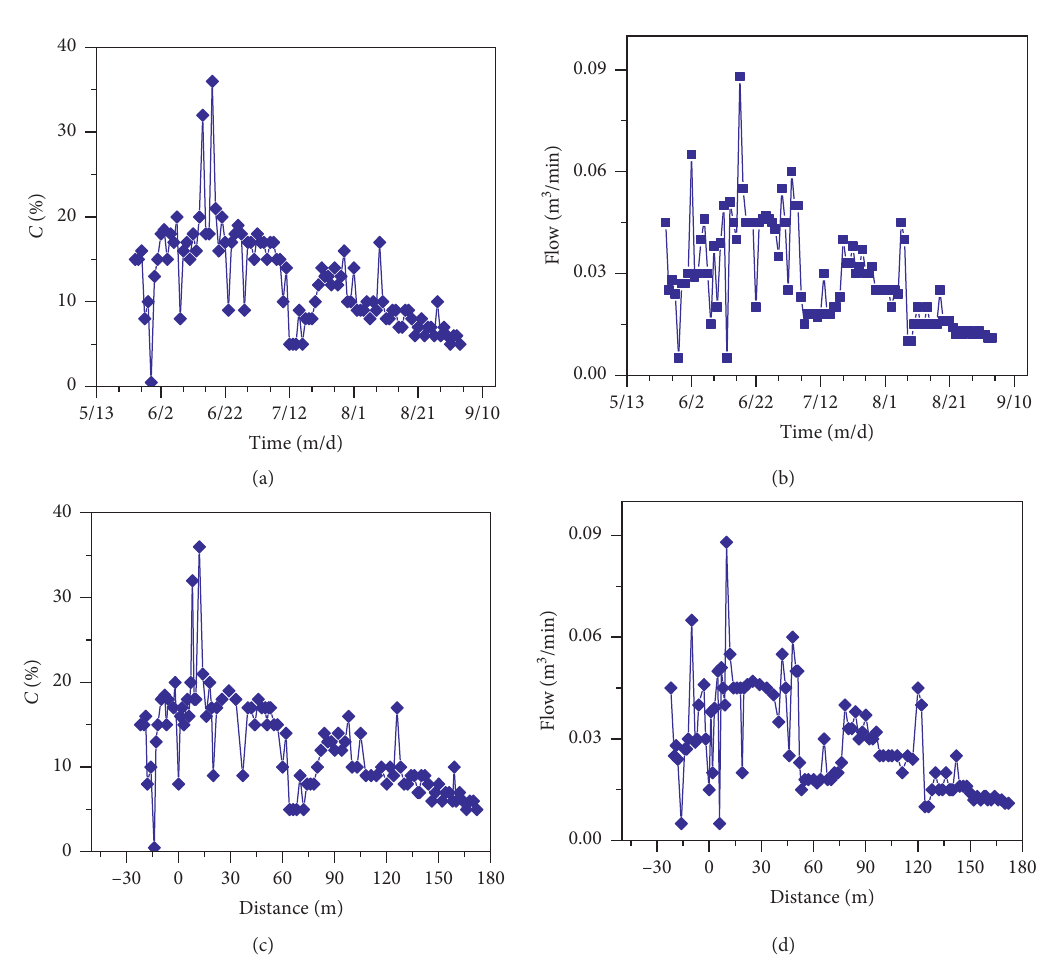
Figure 12: Gas monitoring data in no. 1 borehole of group 18.